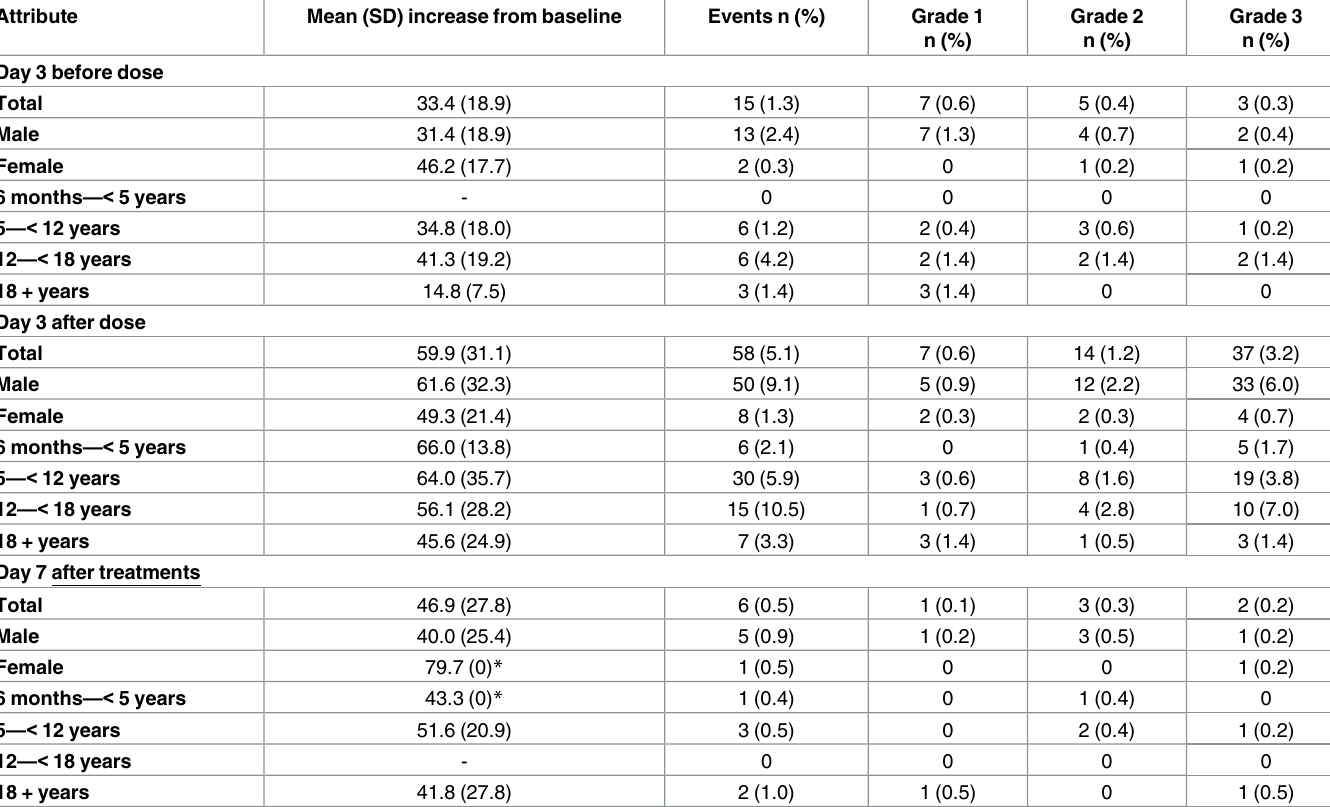
Table 7. QTcF extreme prolongation from baseline to Day 3 and Day